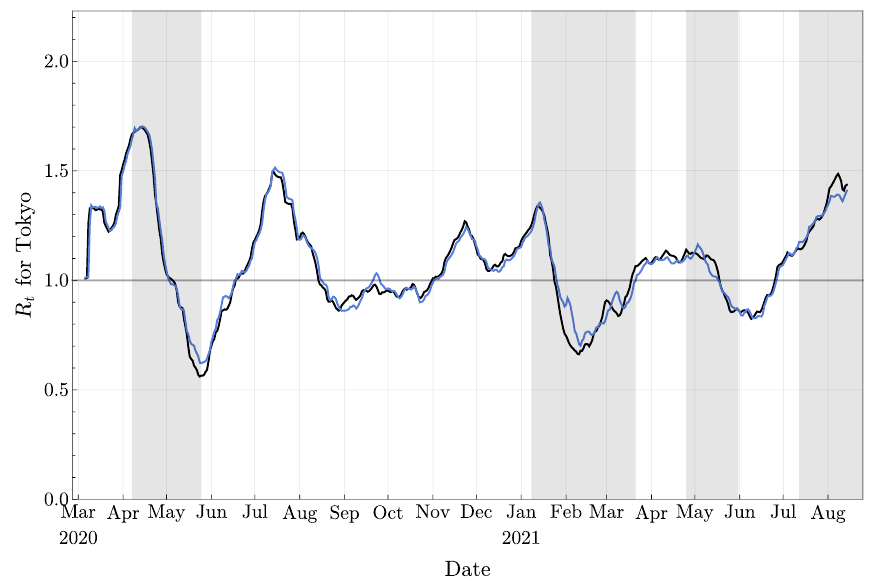
Figure 11. The mean values of the effective reproduction number obtained with two independent experiments, each involving 100 000 particles and the same